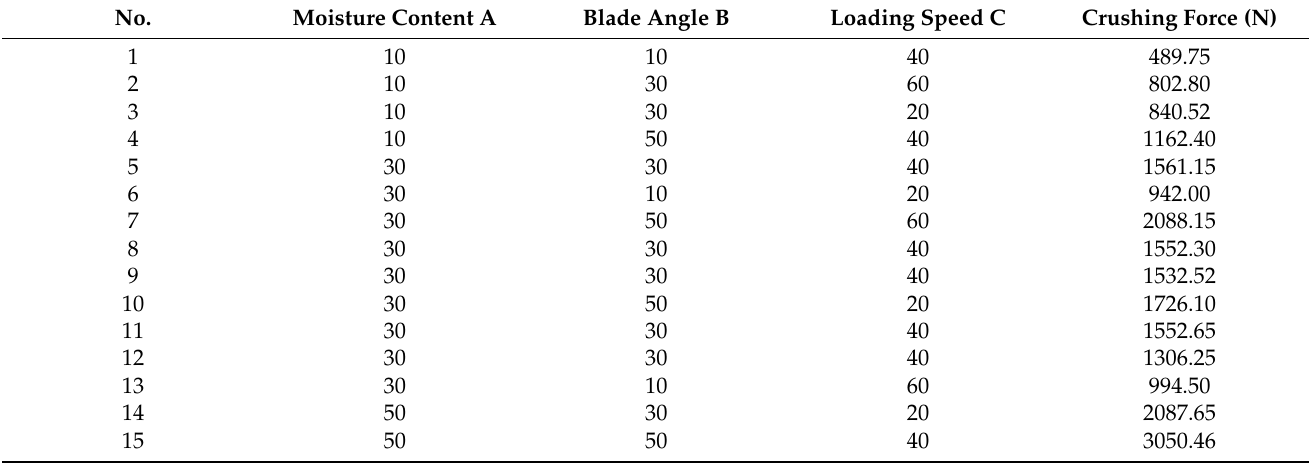
Table 2. Result of corn bale sample crushing